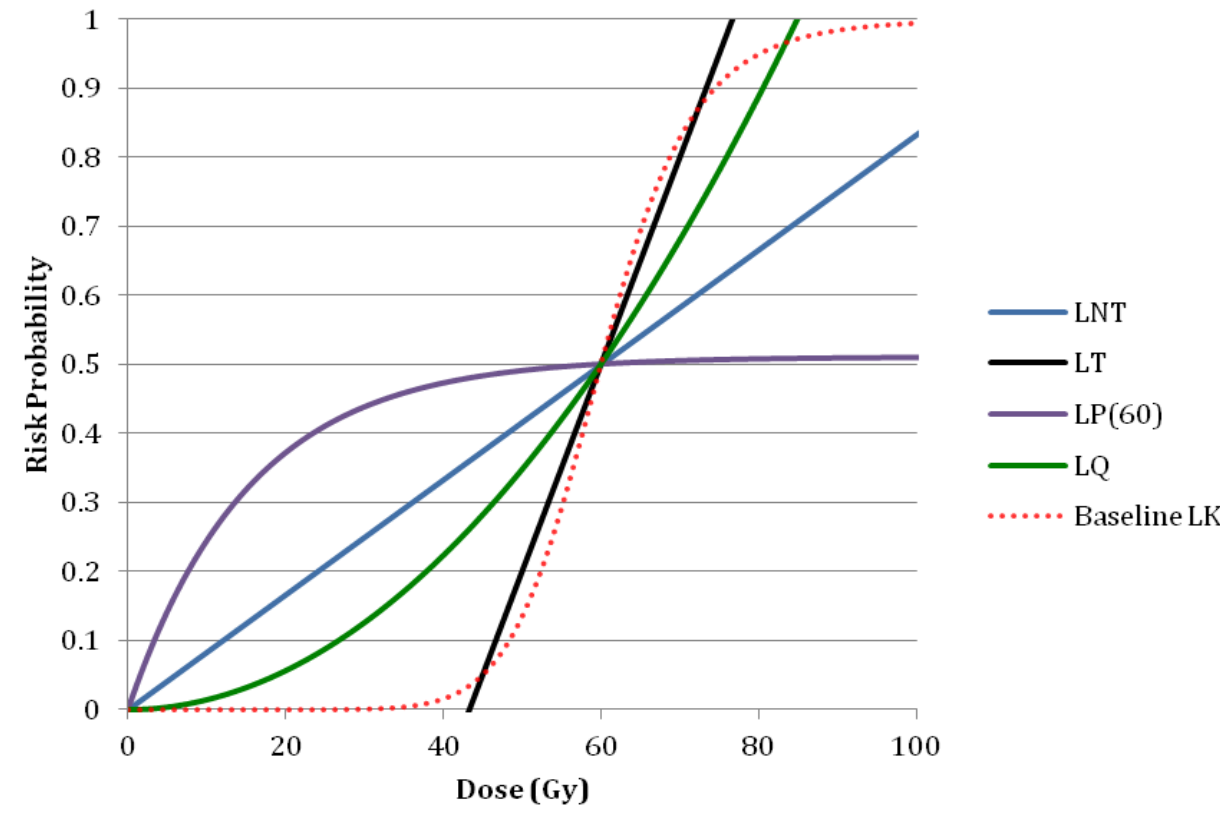
Figure 1. Alternative risk models used to test the sensitivity of rNTCP to the shape of the model used. LNT is the linear no-threshold model, LT is the linear threshold model, LP(60) is the linear plateau model, and LQ is the linear quadratic